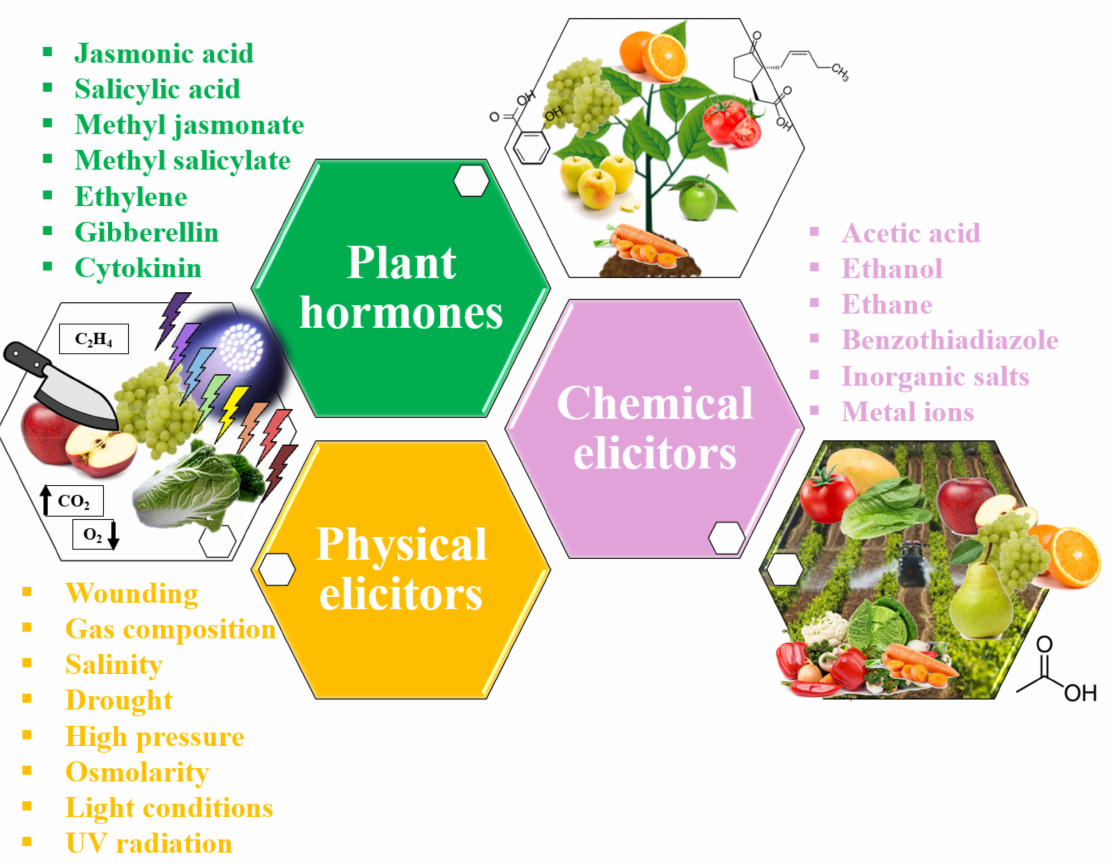
Figure 3. Summary of abiotic stresses applied as plant